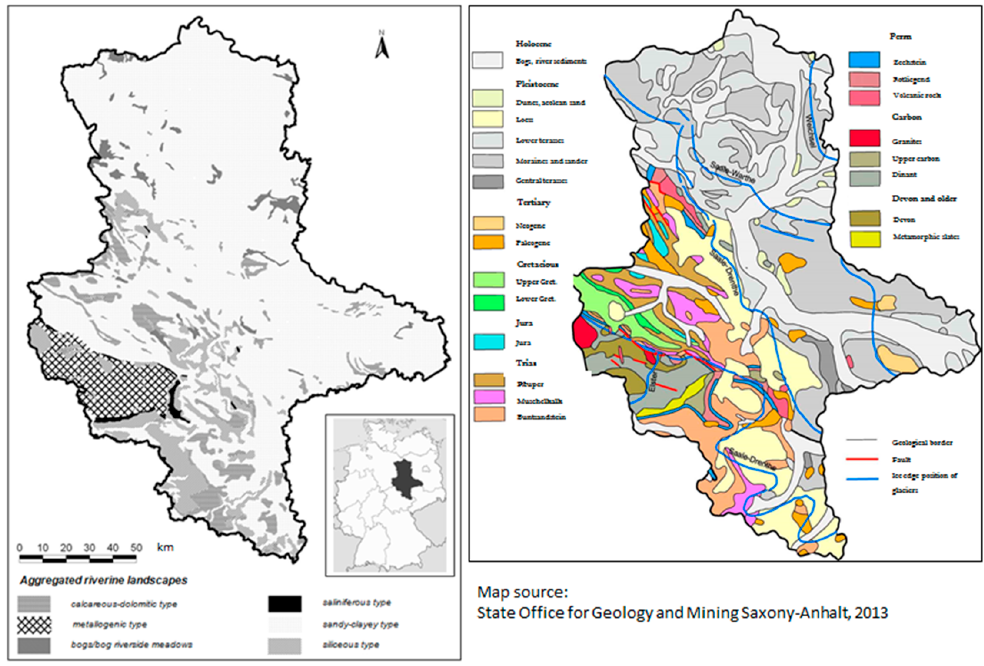
Figure 1. Aggregated riverine landscapes in Saxony ‐ Anhalt, and the geological setting.